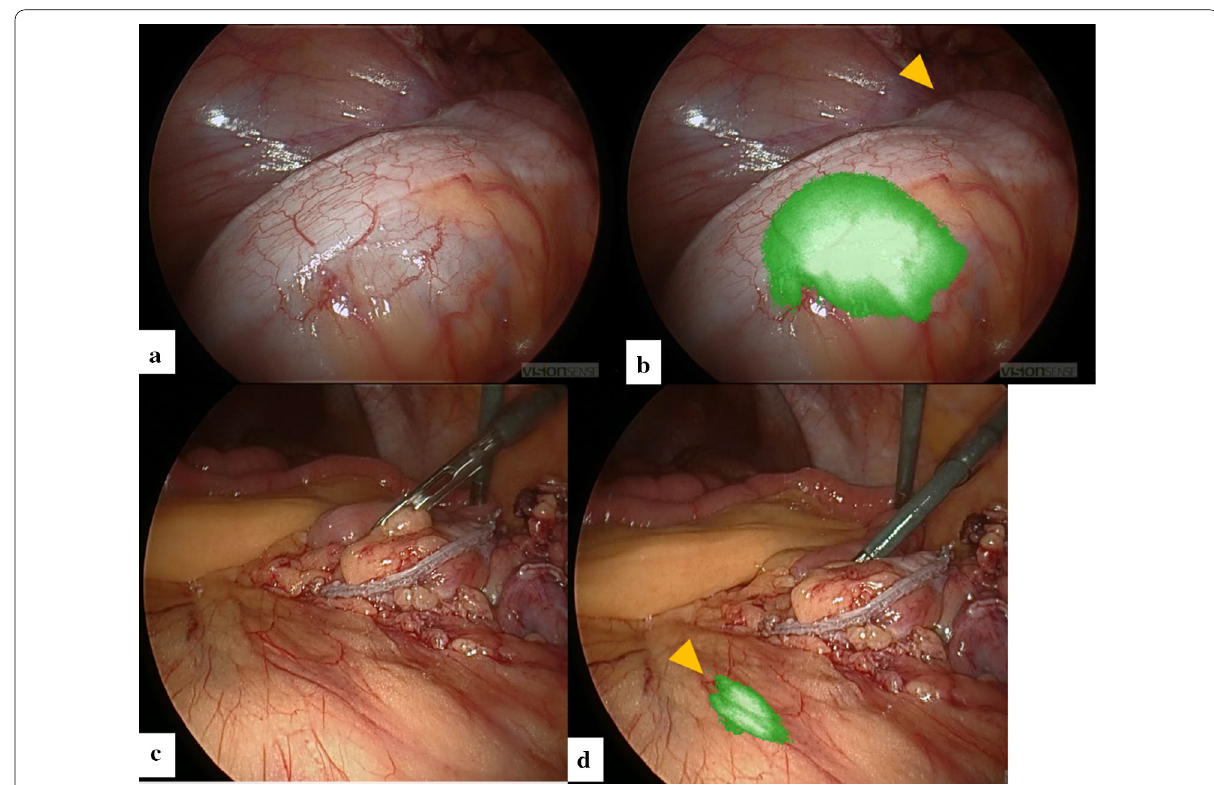
Fig. 3 Intraoperative findings. a White light image: location of the sigmoid colon cancer is unclear. b Full-color near-infrared image. The ICG fluorescence in the transanal ileus tube-tip balloon is confirmed to identify the tumor position. (arrowhead). c White light image: the location of the left ureter is unclear. d Full-color near-infrared image. ICG fluorescence of the ureter is observed in the retroperitoneum (arrowhead), confirming the preservation of the